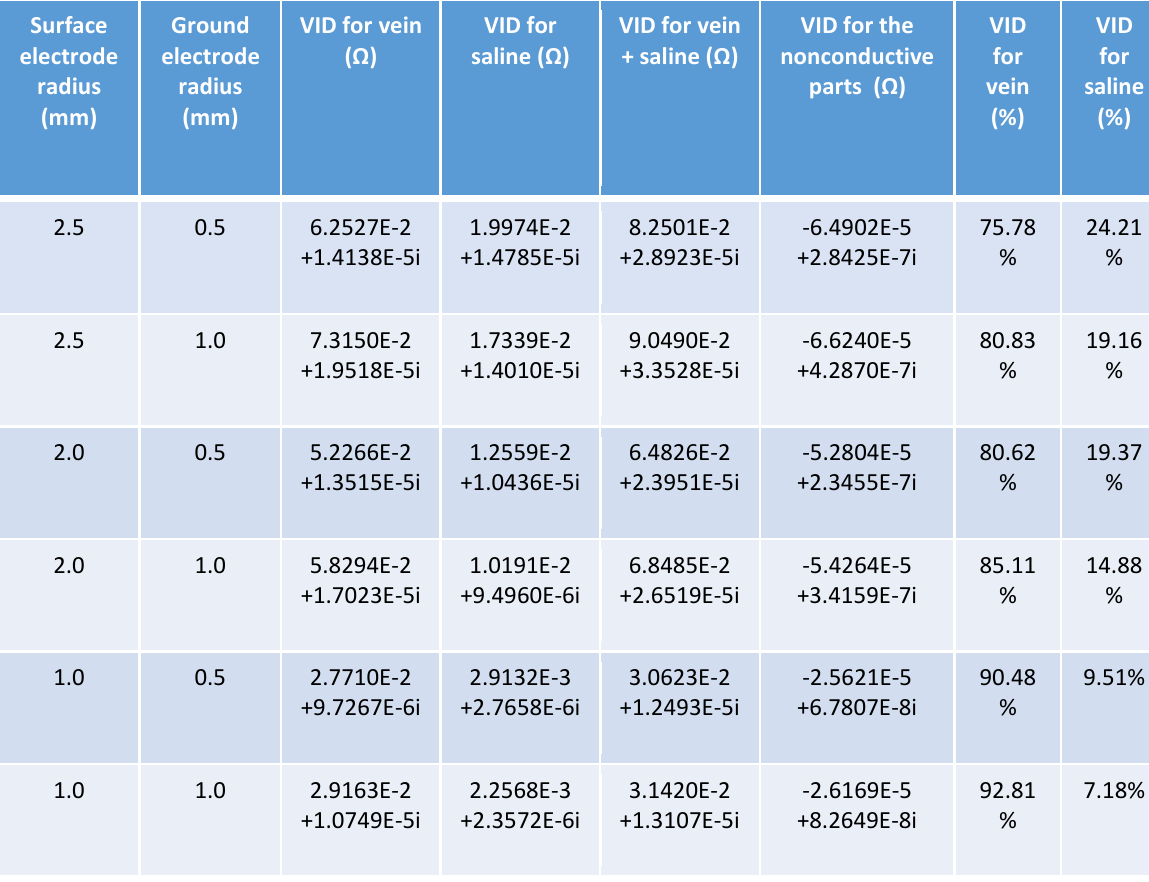
Table.5: Volume integration of Volume Impedance Density (VID) measurements at 1 MHz with all the 28 surface electrodes excited simultaneously as terminals (7 electrodes in 4 rows)